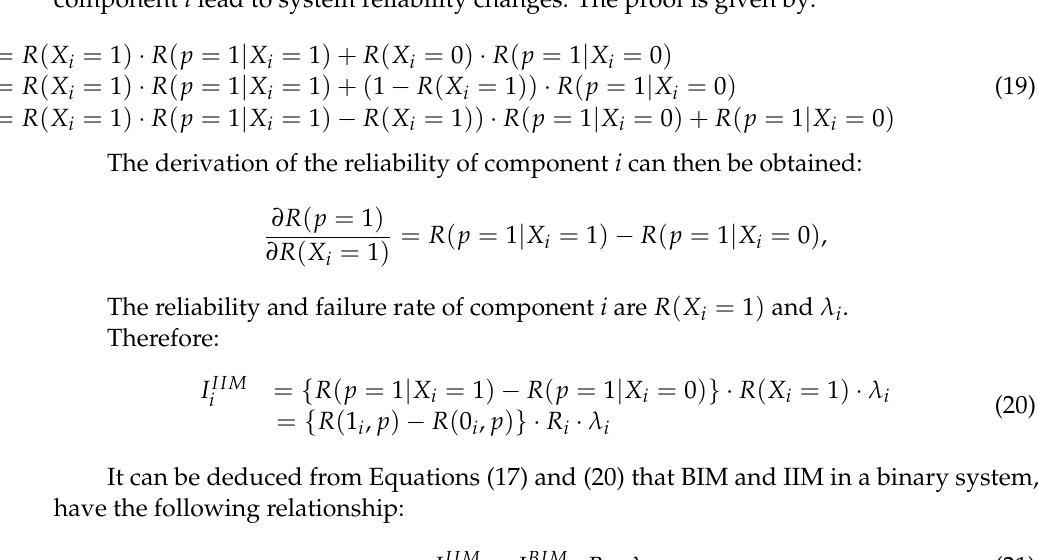
Table 1. IG distribution parameter values of several components. Components